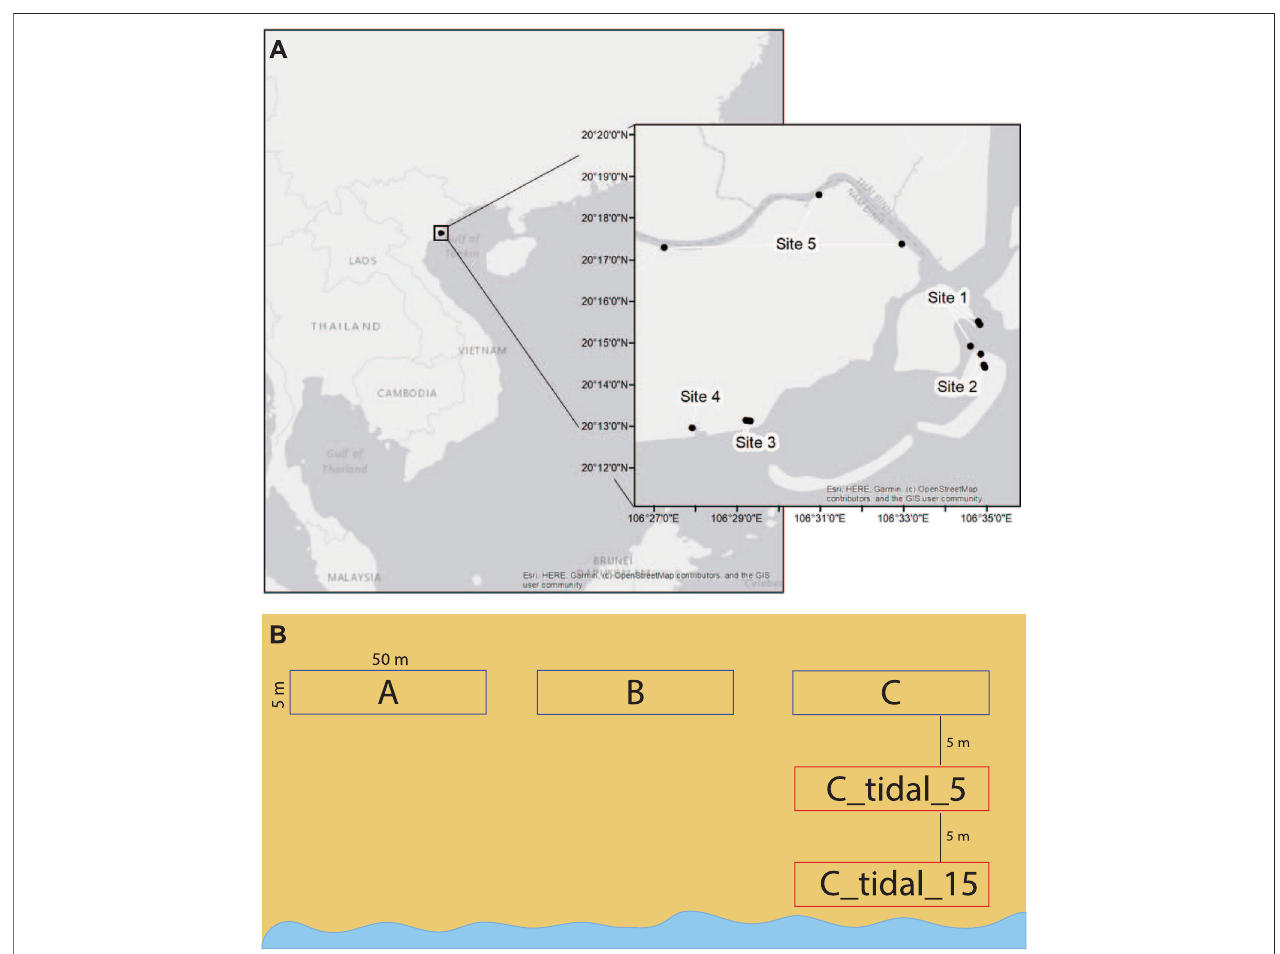
FIGURE1|(A) Siteoverview.Fivesitesweresurveyedforanthropogenicdebris(1 – 5)andfourweresurveyedforecologicalindices(1 – 4forcrabburrowsand1 –